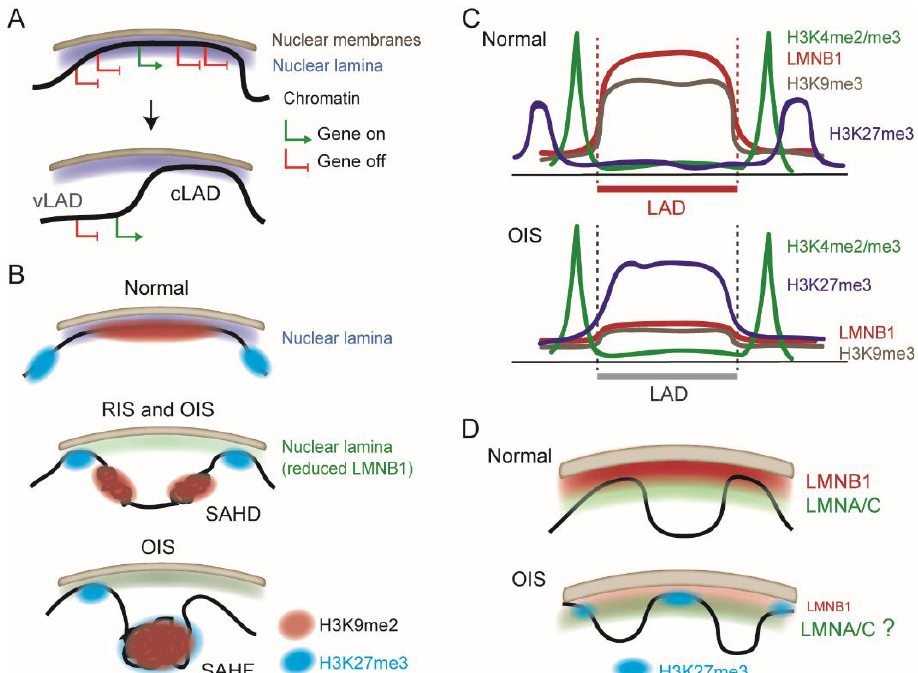
Figure 1. Lamina-associated domains (LADs) are dynamic features of peripheral chromatin architecture in senescence. ( A ) Chromatin association with the nuclear lamina via a LAD. LADs mostly harbor repressed genes, although occasional “escaper” regions contain expressed genes. While constitutive LADs (cLADs) are conserved during differentiation and between cell types, variable LADs (vLADs) are gained or lost; vLAD repositioning does not always concur with a change in gene expression. ( B ) Formation of SAHDs and SAHFs during replication-induced senescence (RIS) and oncogene-induced senescence (OIS). ( C ) Summary of aggregated profiles of LMNB1 and indicated histone modifications across LADs in normal cells and after OIS. ( D ) Speculative model of remodeling of nuclear lamina composition in OIS nuclei. Whereas loss of LMNB1 is documented, whether LMNA/C constitutes the main component of the lamina remains to be examined. OIS LADs are rich in H3K27me3 (see also panel B).